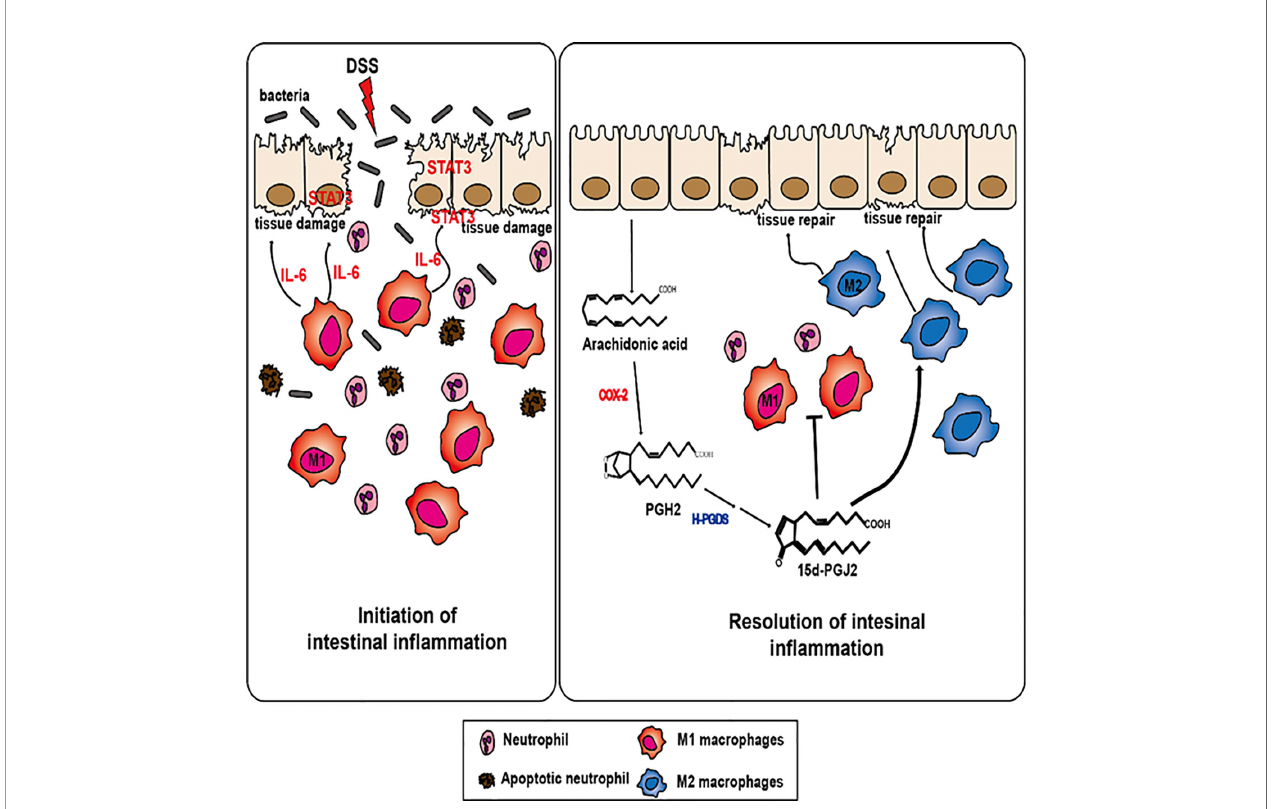
FIGURE 7 | A proposed mechanism underlying the pro-resolving effects of 15d-PGJ 2 on resolution of intestinal in fl ammation. 15d-PGJ 2 , is endogenously generated from arachidonic acid induced by COX-2 and subsequent HPGDS during resolution of intestinal in fl ammation. 15d-PGJ 2 promotes intestinal in fl ammation through regulating macrophage